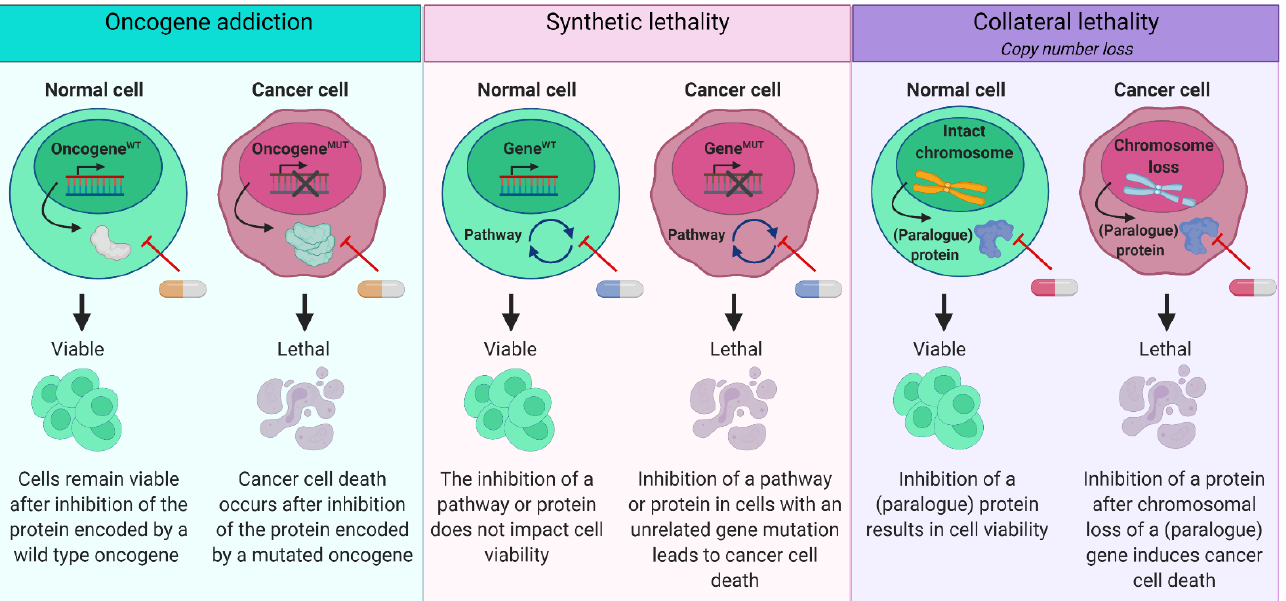
Figure 2. Concepts to identify therapeutic vulnerabilities in cancer cells. Left panel : Oncogene addiction. When a cancer cell harbors an activating mutation of an oncogene, a cancer cell may become completely dependent on this protein product, resulting in cell death upon targeted inhibition. Inhibition of the same albeit wild type protein impacts survival of normal cells less or not at all; these cells do not rely on this protein only for survival. Middle panel : Synthetic lethality. Inhibition of either two proteins or pathways with comparable function does not affect cell survival in normal cells. However, when a cancer cell harbors a gene mutation that inactivates a protein in such a pathway, cancer cells may become fully dependent on the other pathway. Inhibition of the remaining functional pathway will induce specific cancer cell death. Right panel : Collateral lethality. When a tumor suppressor gene is lost through loss of the chromosomal region, other neighboring genes located at that region may become dose-limiting and cause increased sensitivity for inhibiting drugs. Likewise, when a gene is lost or partially lost due to copy number losses, inhibition of a paralogue gene may specifically affect cancer cell viability. Abbreviations: WT: wild type, MUT: mutant.